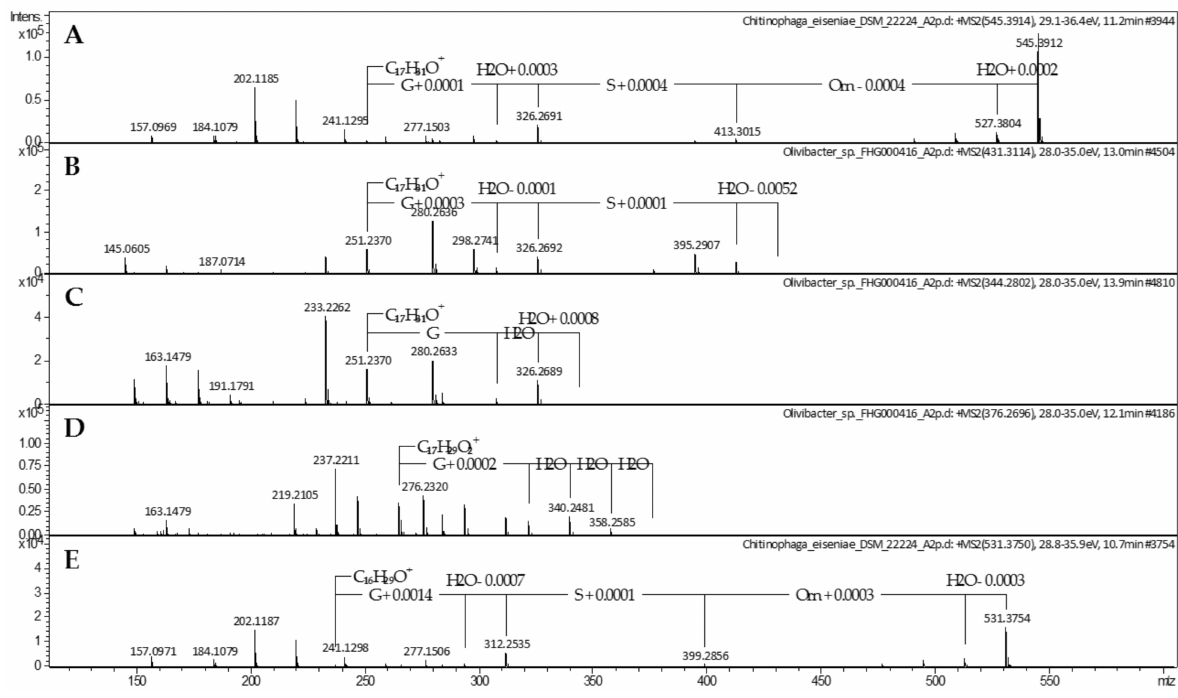
Figure 1. MS/MS spectra of lipoamino acids 1 – 4 ( A – D ) and 7 ( E ) produced by Chitinophaga eiseniae DSM 22224 ( 1 , 7 ) and Olivibacter sp. FHG000416 ( 2 – 4